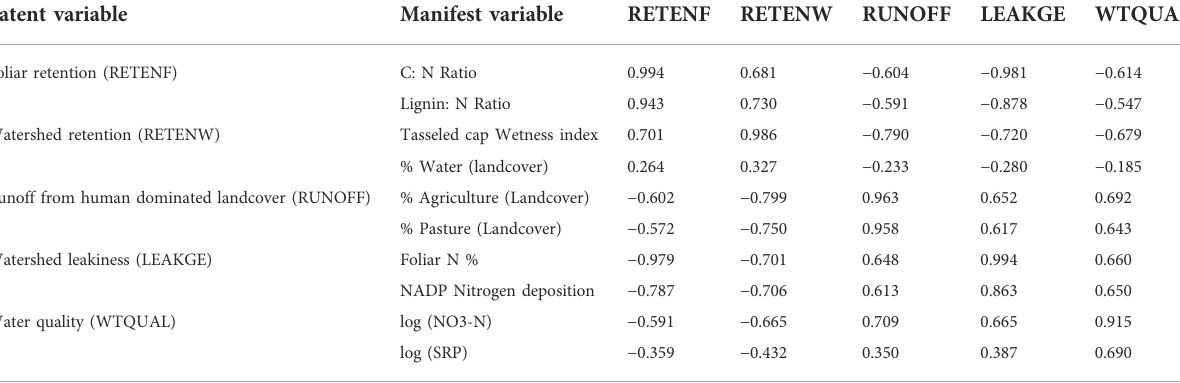
TABLE 4 Outer correlation matrix (correlationsof manifest variables with latent variables) of the reducedvariable model; shaded cells indicate latent variable blocks (in columns) associated with each manifest variable (in rows), numbers in bold typeface represent the maximum row-wise correlation of the manifest variable with latent variables.